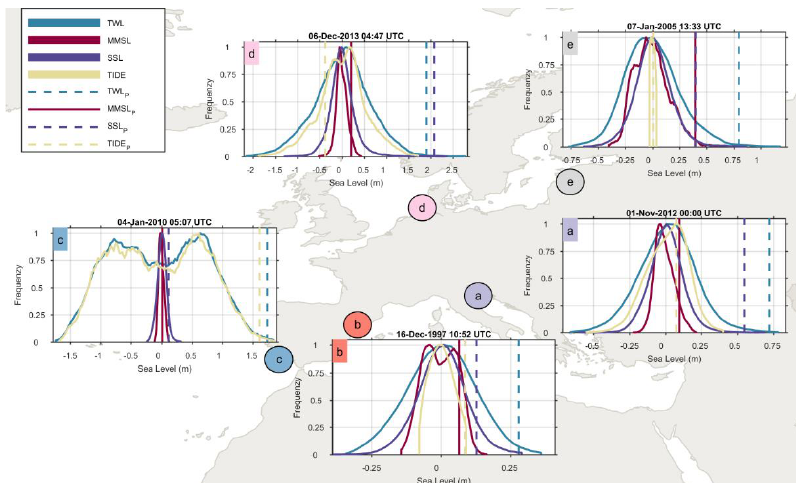
Figure 11. Extreme events registered in the storm impact database and captured by altimetry dataset. Curves represent the histogram of each sea level component (TIDE, SSL and MMSL) in the area and vertical lines mark the magnitude of each component at the peak of the extreme event.